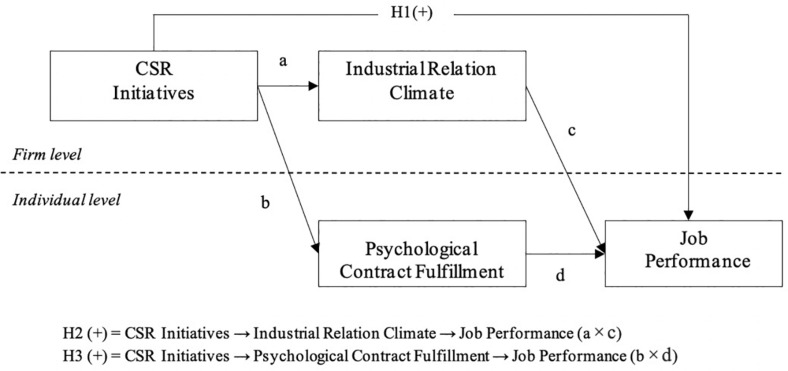
Conceptual model.